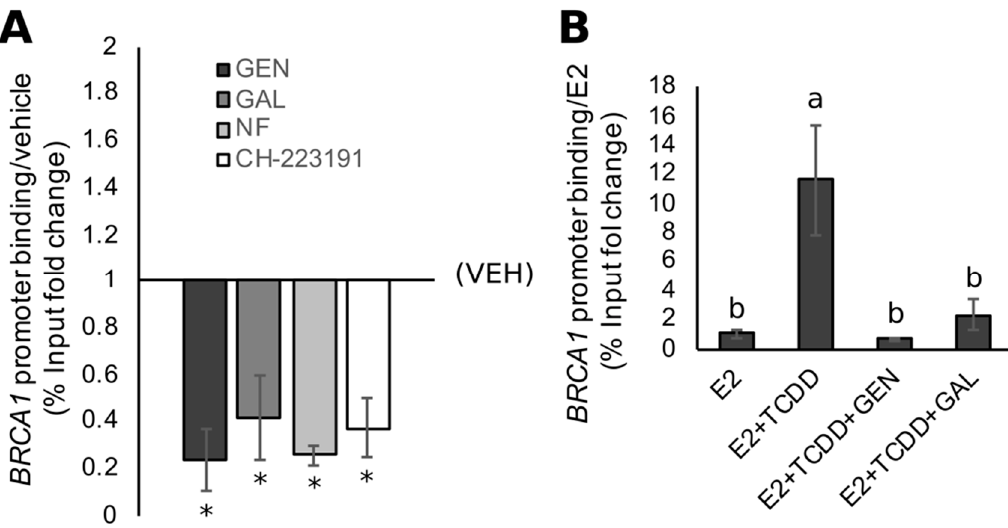
Figure 5. Antagonism toward AHR binding at the BRCA1 promoter by GEN. Results show the relative binding of AHR at the BRCA1 promoter from chromatin immunoprecipitation (ChIP) assays in ( A ) HCC38 cells treated with GEN and various AHR antagonists; and ( B ) MCF7 cells treated with estradiol (E2) and 2,3,7,8-tetrachlorodibenzo-p-dioxin (TCDD) in the presence or absence of GEN and GAL. Relative binding was determined as the percent input (ChIP / Input*100) from treated samples normalized to VEH ( A ) or E2 ( B ) controls. Bars represent sample means ± SEM from ≥ 3 biological replicates from individual experiments. Means with di ff erent letters (a > b) or asterisks (*) indicate significance (*, p <